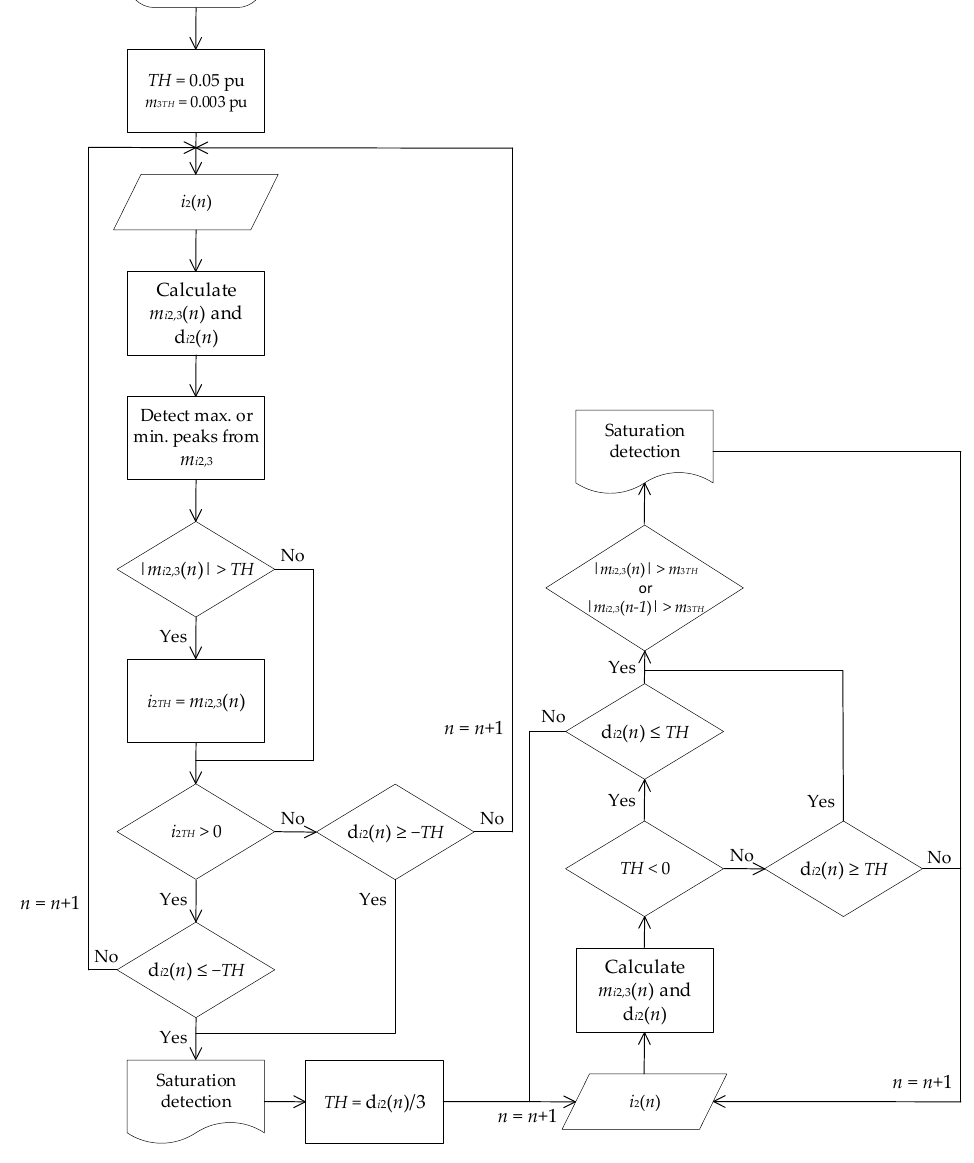
Figure 5. Flowchart of the CT saturation detection algorithm. ( TH : threshold value, m 3TH : third moment threshold value, i 2 : secondary CT current, m i 2,3 : moving third-order central moment, d i 2 : second-order difference function, n : sample number).